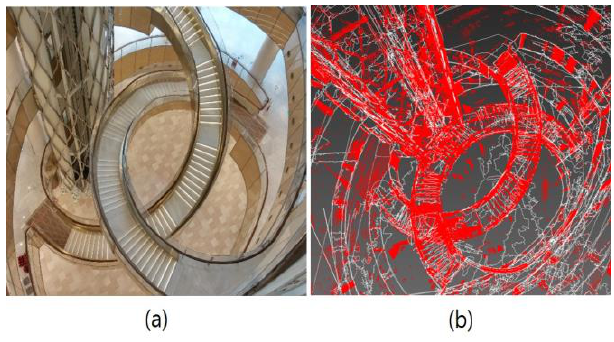
Figure 4. Detail components of 3D geometric drawings